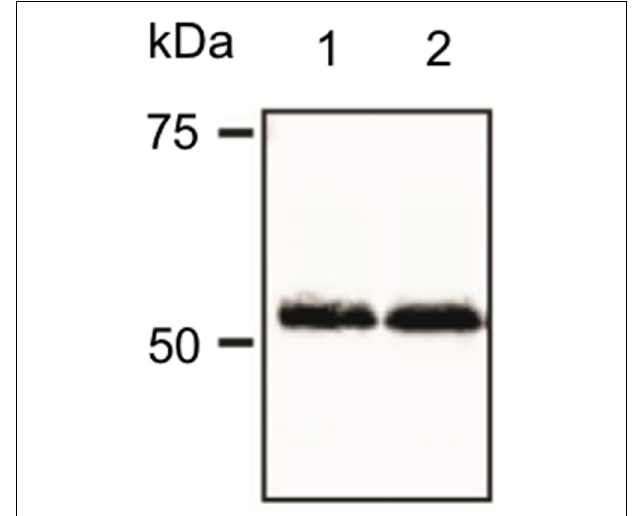
FIGURE 1 | Verification of antibody specificity. Example of a western blot showing binding specificity of the dopamine D2-like receptor (D2R) antibody used in the immunohistochemistry experiments. The antibody labeled a band of ca. 55 kDa, corresponding to the reported kDa weight of the target receptor as reported by others (Gemechu et al.,